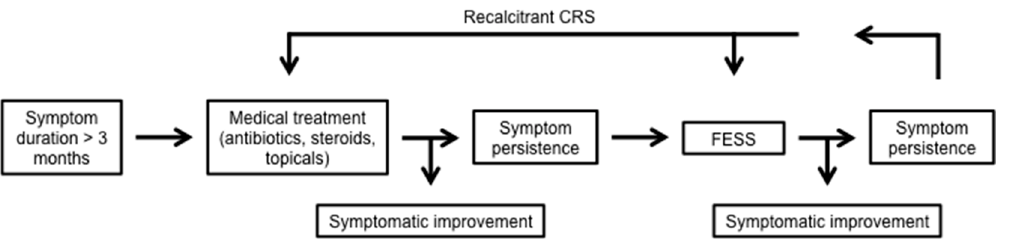
Figure 4. Treatment algorithm for chronic rhinosinusitis (CRS). CRS is diagnosed after symptoms, including headache, hyposmia, rhinorrhea, and nasal congestion persist for greater than three months. Treatment is initiated medically with oral antibiotics and steroids as well as topical steroids and nasal irrigation. Should symptoms persist, patients are offered surgical intervention with functional endoscopic sinus surgery (FESS). Continued symptoms of recalcitrant CRS are managed with repeated courses of culture-directed antibiotics, steroids, and topical treatment with revision sinus surgery when indicated.